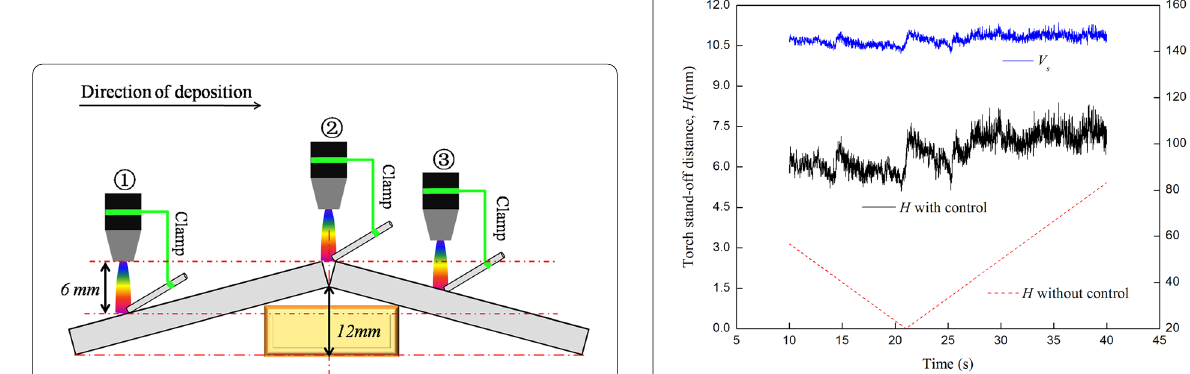
Figure 15 Total voltage and wire feed rate during sloping-substrate